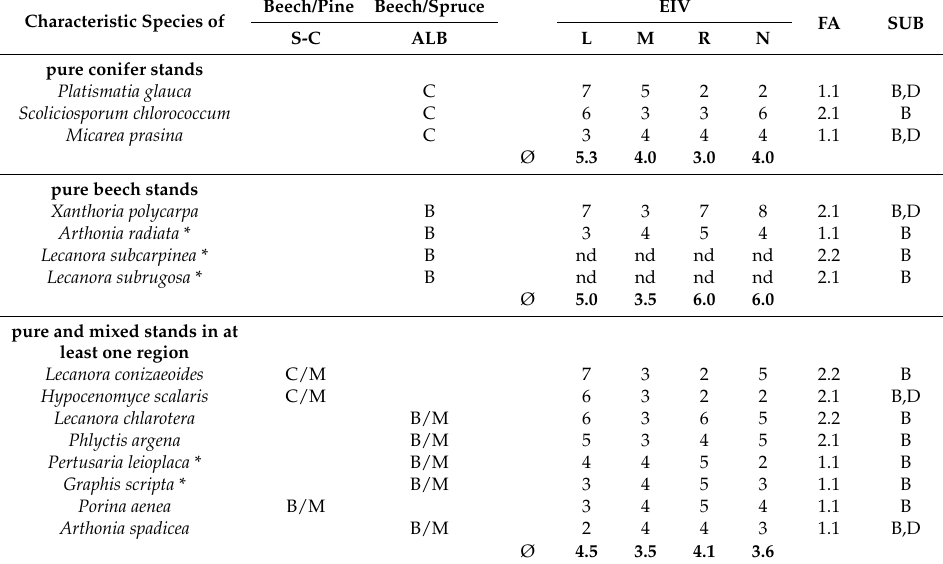
Table 6. Lichen species associated with pure conifer, pure beech and mixed stands in Schorfheide-Chorin (S-C) and Schwäbische Alb (ALB). For details see Table 4. nd = no data available. SUB gives the preferred substrate species grow on (B = bark, D = deadwood) as listed by Schmidt et al. [63]. Rocks as substrate was not included. * marks threatened and protected species (see Table A4).